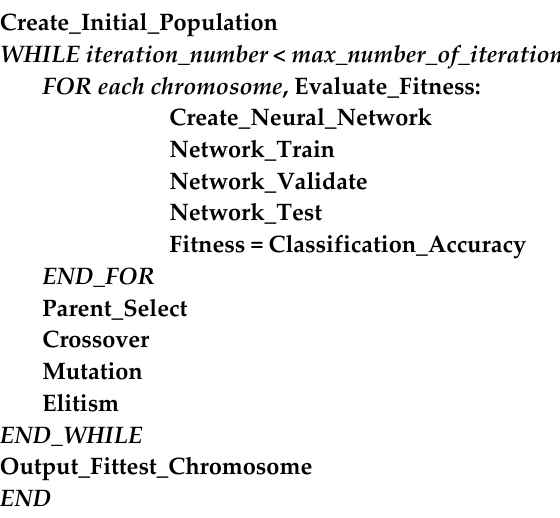
Figure 5. Pseudocode of the proposed GA-based feature selection algorithm. GA: genetic